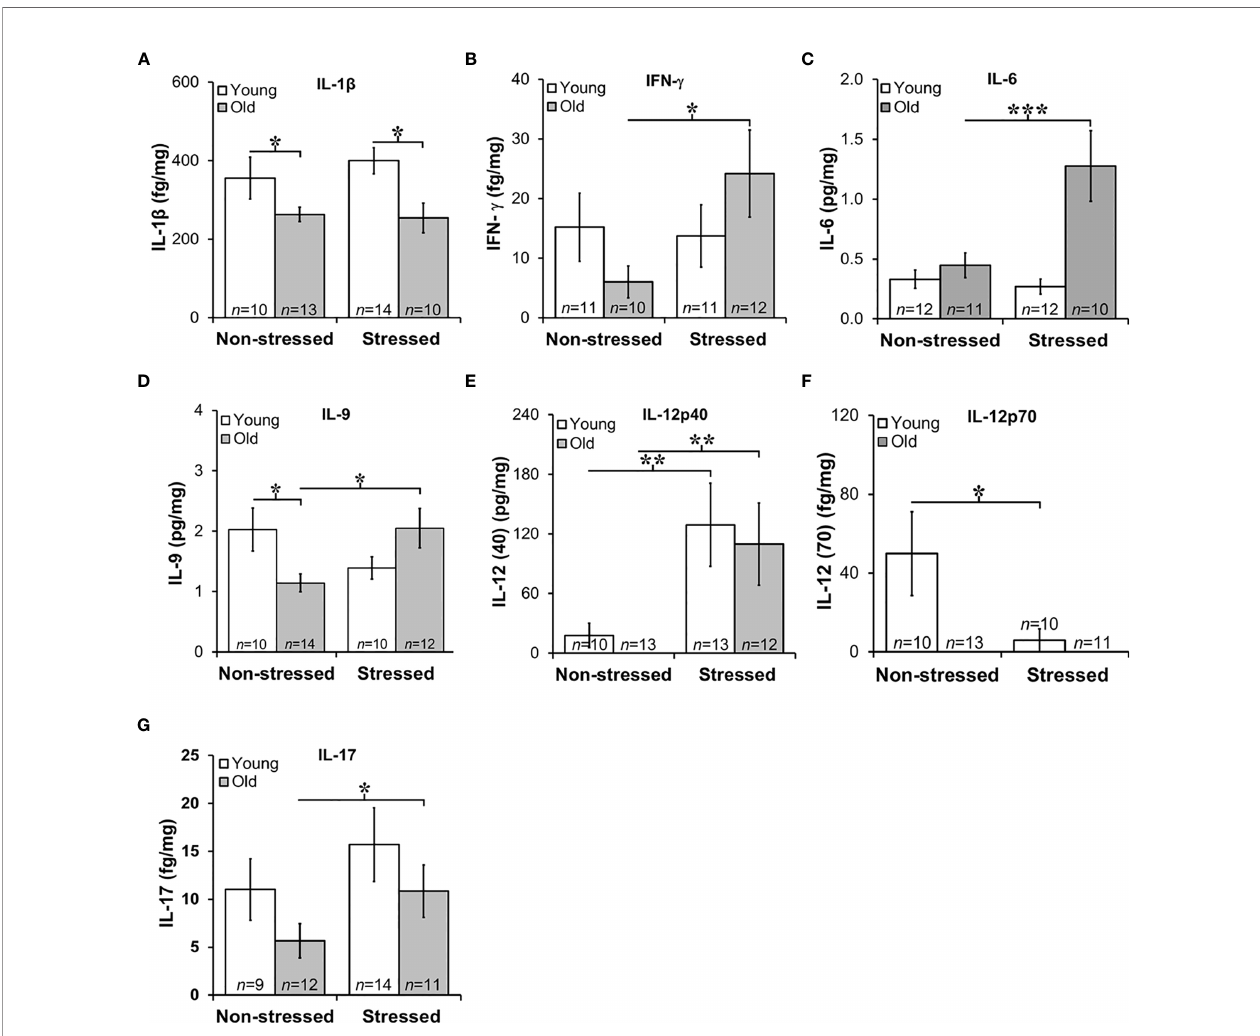
FIGURE 7 | Expression of Interleukins in Prostate Tumors. (A) IL-1 b expression was lower (p<0.05) in old than in young tumors, regardless of the stress-related group. (B, C) There was an effect of stress on IFN- g and IL-6 tumor expression in old mice such that stress mice had elevated tumor expression than non-stressed mice (*** p < 0.001). (D) Tumors from old stressed mice expressed higher levels of IL-9 than young stressed mice, but in non-stressed mice, tumor IL-9 levels were lower in old than young mice. (E) Tumor levels of IL-12p40 were low in non-stressed mice, regardless of age. In both young and old mice stress signi fi cantly increased (** p < 0.01) tumor IL-12(p40) expression compared with non-stress age-matched mice (F) Overall, IL-12p70 expression in prostate tumors was lower than IL-12p40 shown in (E) , with low levels in old mice regardless of stress group. Still, in young and old mice, psychosocial stress reduced (** p < 0.01) tumor IL-12p70 expression. (G) Prostate tumor IL-17 levels were low in all treatment groups, but a stress-related increase (* p < 0.05) in tumor levels of IL-17 was observed in old compared with young